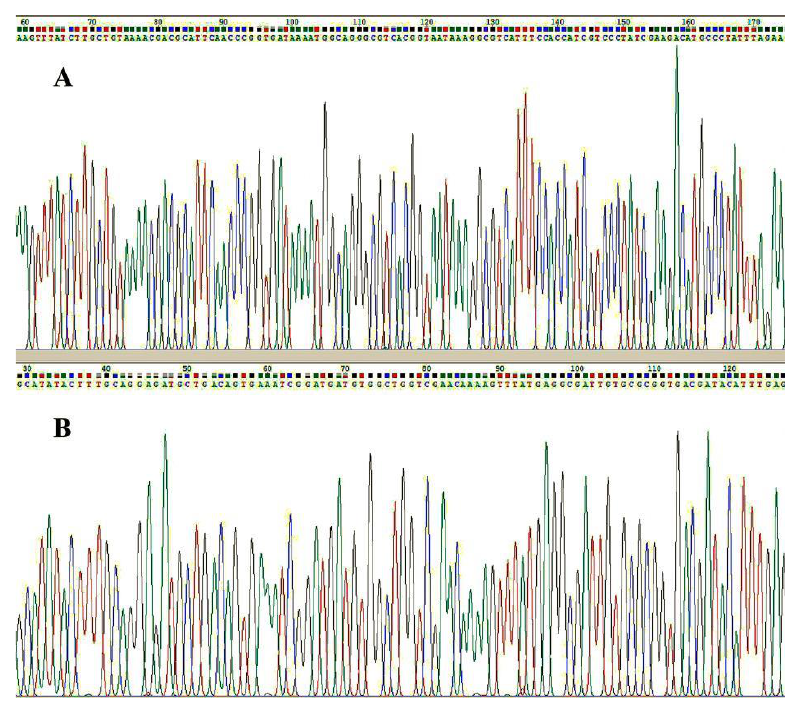
Figure 2. A unique DNA fragment of Coxiella burnetii was verified by Sanger sequencing in the resected tissue sample of Patient No. 5 ( A ). The PCR primers of Coxiella burnetii for verification were TAACGCAAGGCGGTGATTTAG and CGATAGGGACGATGGTGGAA . The sequence ID of the target species was CP040059.1, and the location of the target sequence was 1: 214,444 to 214,577. A unique DNA fragment of Bartonella species was verified by Sanger sequencing in the resected tissue sample of Patient No. 4 ( B ). The PCR primers of Bartonella species for verification were TGGTGGTCAGCGTTTTGGT and CCTCAAATGTATCGTCACCGC . The sequence ID of the target species was AP019773.1, and the location of the target sequence was 1: 687,822 to 687,945. The colored curves represented different basic group such as green for adenine, red for thymine, black for guanine and blue for cytosine.